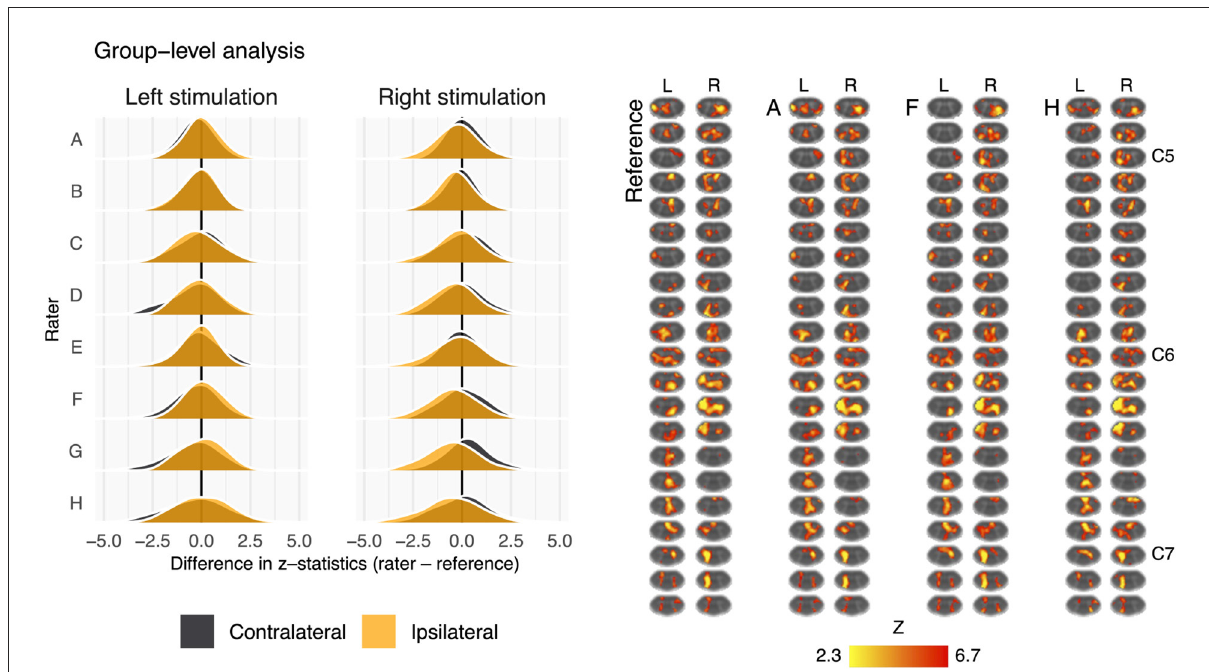
FIGURE6 Summary of the group-level activation maps. Left: distribution of group-level activation z-statistics in the left and right hemicords for left- and right-sided stimulation trials. The shape and centering of the distributions are generally similar across all raters illustrating no systematic difference in average z-score. Right: group-level activation maps from the reference, rater A, rater F, and rater H. Activation is thresholded at Z-score > 2.3 (cluster corrected p < 0.05). Data have been transformed to the standard PAM50 template space, and the approximate level of C5–C7 spinal levels are indicated (L, left; R, right sided stimulation).